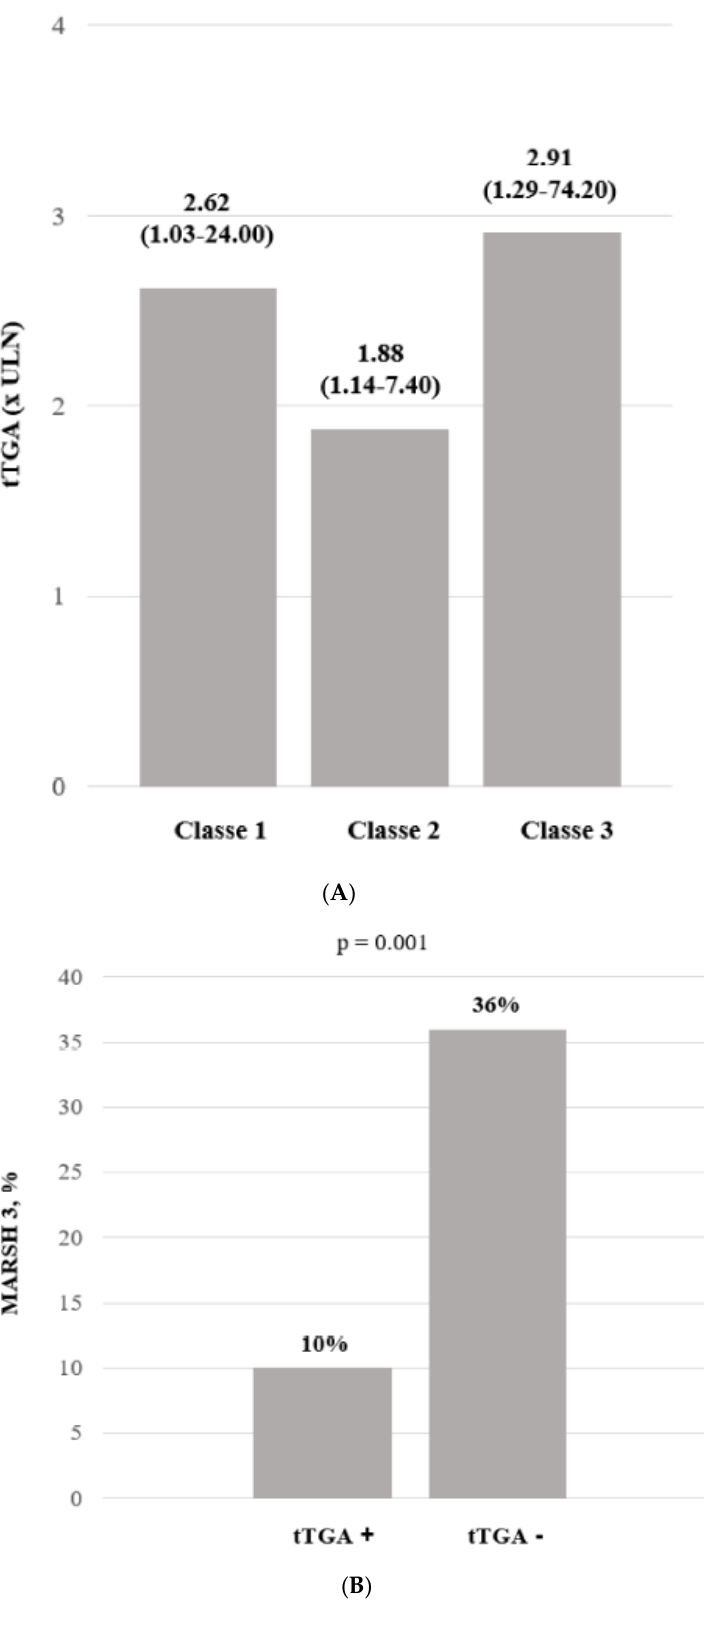
Figure 2. ( A ): tTGA levels (folds increased above ULN) during follow-up in the three classes; ( B ): Percentage of patients with Marsh grade 3 at follow-up